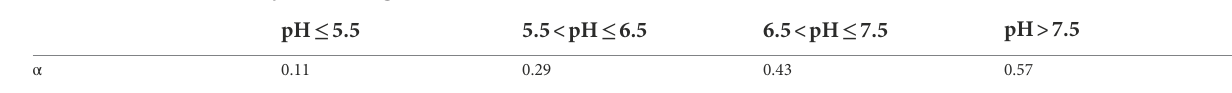
TABLE 2 Selection criteria of pH influencing